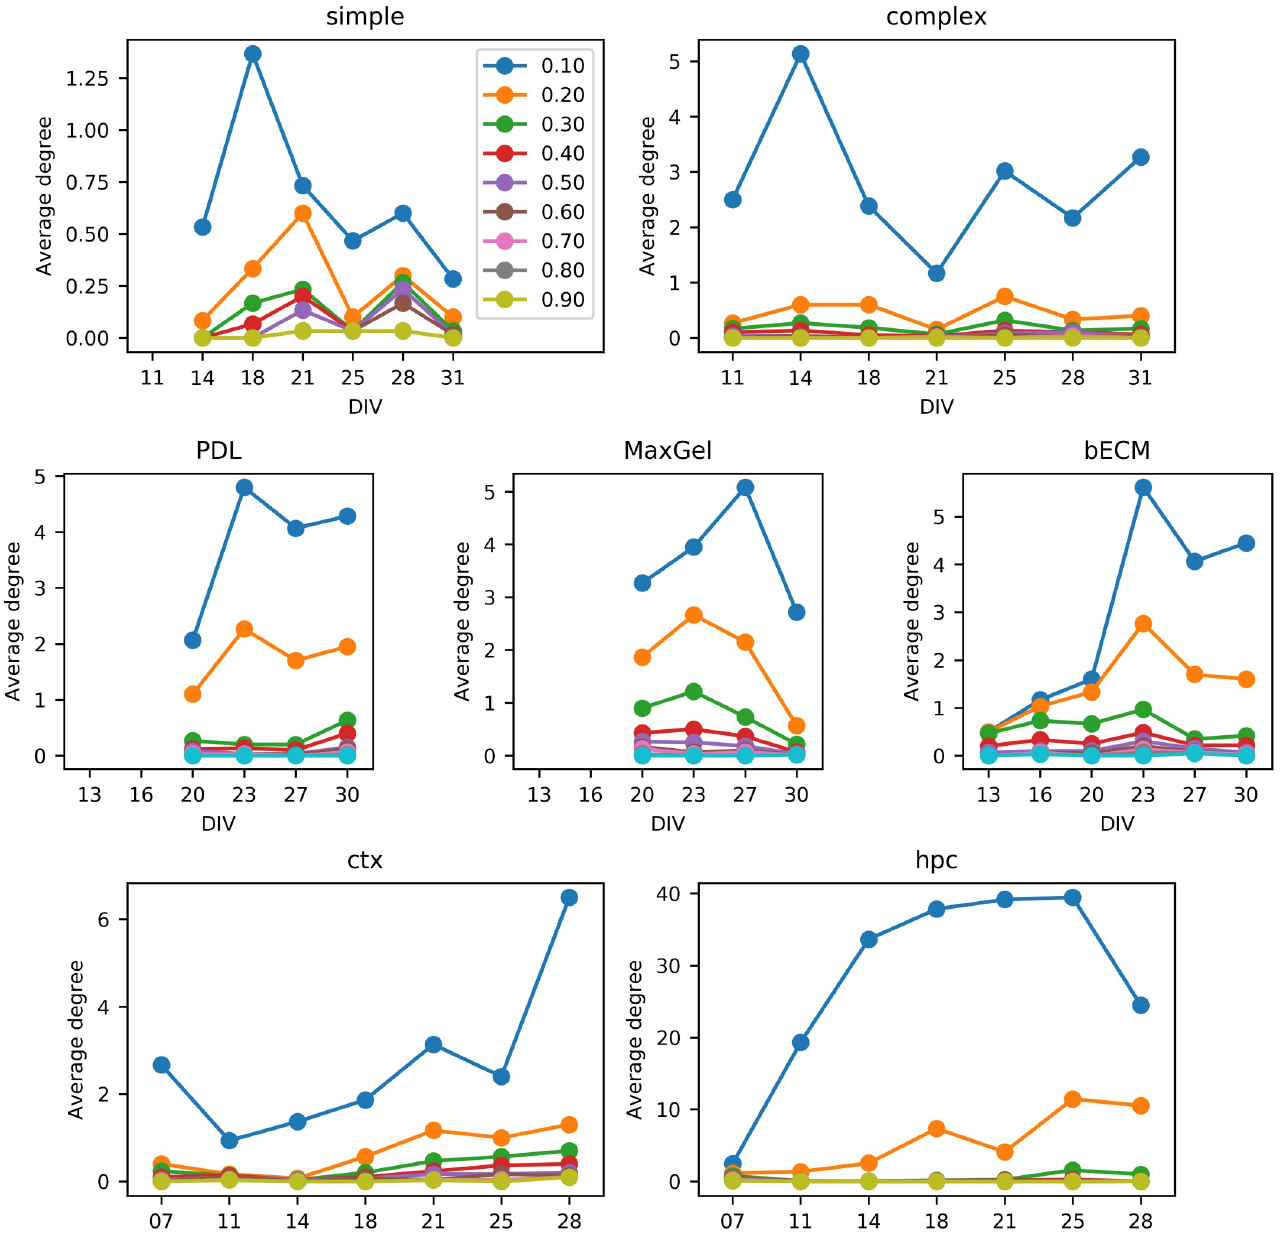
Fig 10. Average degree as a function of cross-correlation threshold for the Culture Complexity (top), Extracellular Matrix (middle), and Neuronal Type (bottom) datasets. Changes in the threshold do not affect the relative trend on graph properties, only the magnitude.